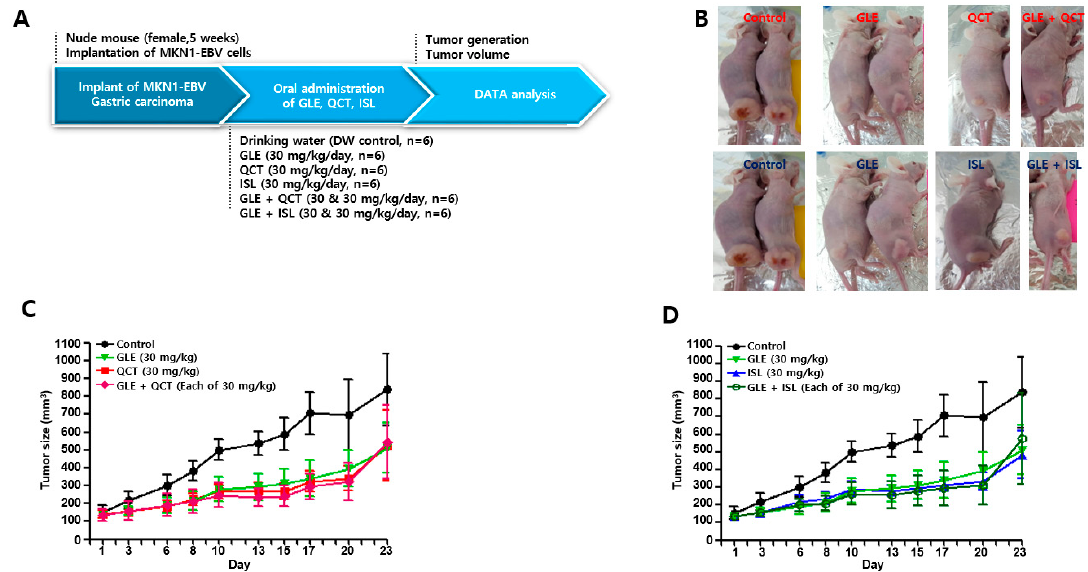
Figure 2. Cotreatment with GLE and QCT at relatively high concentration did not synergistically suppress EBVaGC development in xenograft mouse model. ( A ) A schematic diagram of the antitumor assay carried out using xenograft mouse model. ( B ) A representative image of a nude mouse bearing MKN1-EBV-derived tumors. ( C ) The determination of the antitumor effects of relatively high- concentration GLE (30 mg/kg), QCT (30 mg/kg) and mixture of GLE and QCT (30 + 30 mg/kg) in MKN1-EBV-derived tumors in nude mice. ( D ) The determination of the antitumor effects of high- concentration GLE (30 mg/kg), ISL (30 mg/kg) and a mixture of GLE and ISL (30 + 30 mg/kg) in MKN1- EBV-derived tumors in nude mice. Any group was not statistically different in tumor sizes. GLE, QCT and ISL: Ganoderma lucidum extracts, quercetin, and isoliquiritigenin, respectively.